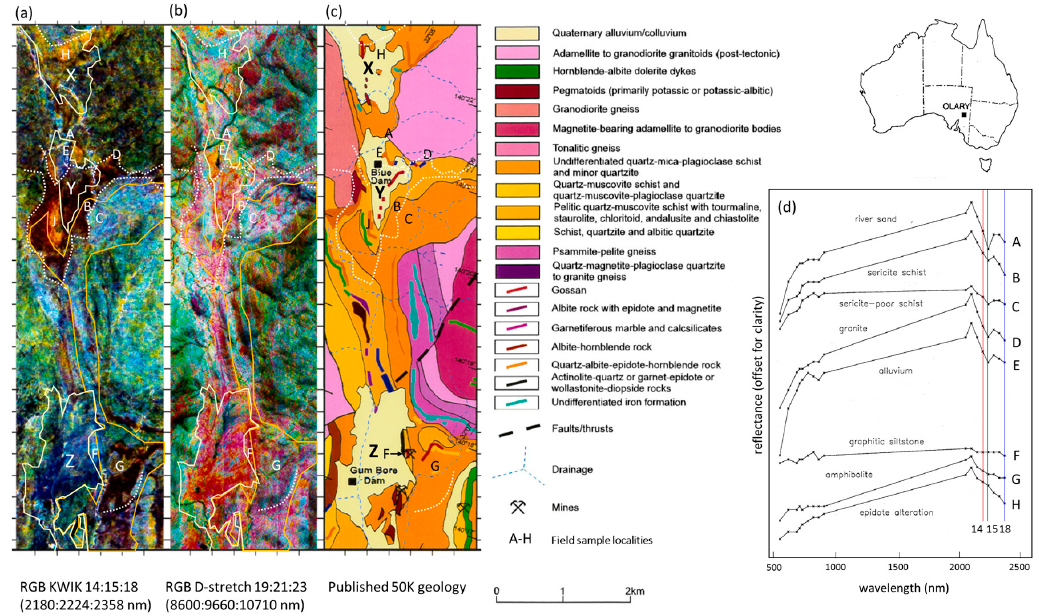
Figure 2. Airborne Geoscan Mk II results (~1992) for Olary, South Australia (scene center − 32.0981 ◦ latitude 140.3228 ◦ longitude). ( a ) KWIK residual RGB color composite of SWIR bands approximately − 32.0981° latitude 140.3228° longitude). ( a ) KWIK residual RGB color composite of SWIR bands 14 (2180 nm): 15 (2224 nm): 18 (2358 nm); ( b ) Inverted de-correlation stretch RGB color